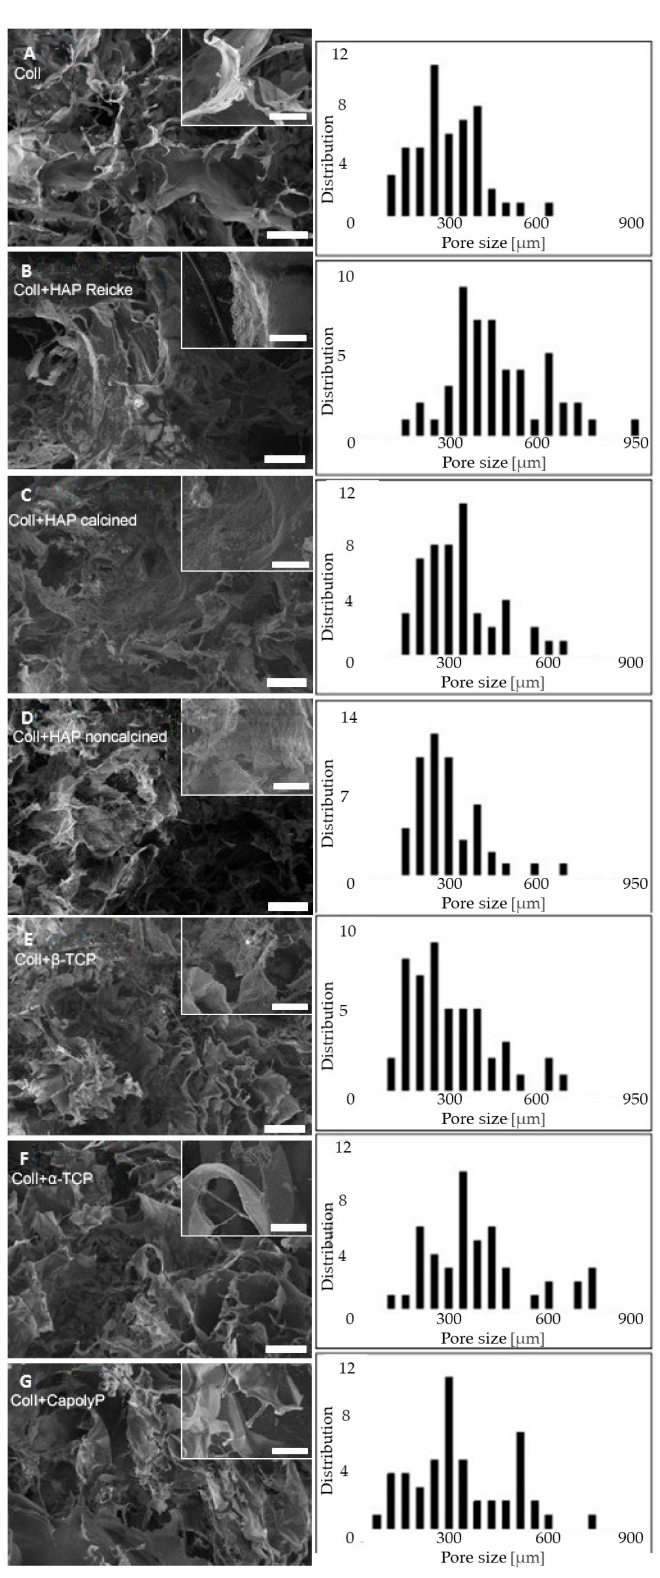
Figure 1. In the left column, there are SEM images of each scaffold, magnification of 222 × . Scale bar 200 µ m (scaffold morphology), 50 µ m, respectively (pore sizes). In the right column, there is the visible pore size distribution of prepared scaffolds. Coll ( A ), ColI+HAP Reicke ( B ), ColI+HAP calcined ( C ), ColI+HAP noncalcined ( D ), ColI+ β -TCP ( E ), ColI+ α -TCP ( F ) and ColI+CapolyP ( G